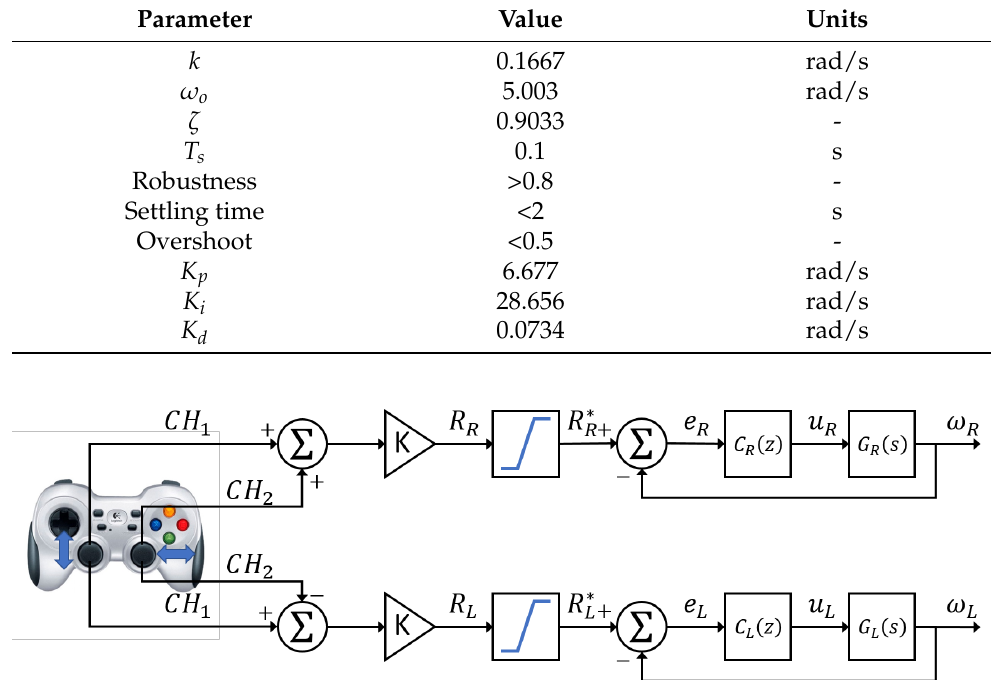
Figure 4. Control scheme for the speed control system. CH 1 and CH 2 represent the gamepad gestures; ω R and ω L represent the controlled wheel speed for the right side and the left side, respectively.